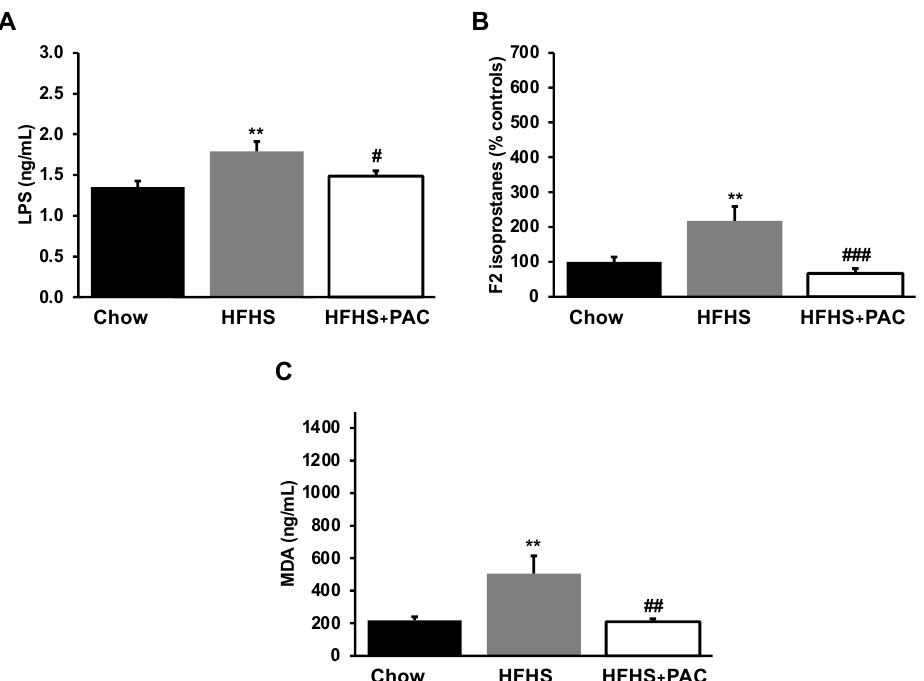
Figure 4. Impact of PAC in inflammatory and OxS markers in HFHS-fed mice. At sacrifice, plasma ( A ) lipopolysaccharide (LPS), ( B ) F2-isoprostanes and ( C ) malondialdehyde (MDA) concentrations were determined as described in Materials and Methods. Results are presented as mean ± SEM for n = 12–16 mice/group. ** p < 0.01 vs. chows; # p < 0.05, ## p < 0.01, ### p < 0.001 vs. HFHS mice.